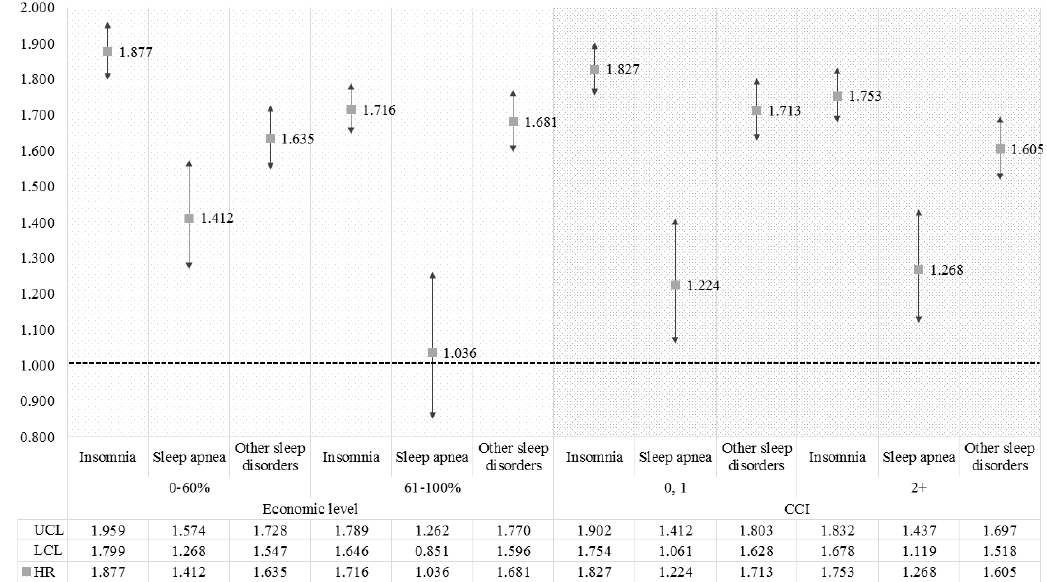
Figure 3. The results of the sub-group analysis for survival analysis according to the economic level and Charlson comorbidity index (CCI). The HR was calculated by survival analysis to investigate the association between sleep disorder and migraine. Results were considered statistically significant if each bar marked to SD did not reach the cut-off line of 1.000.